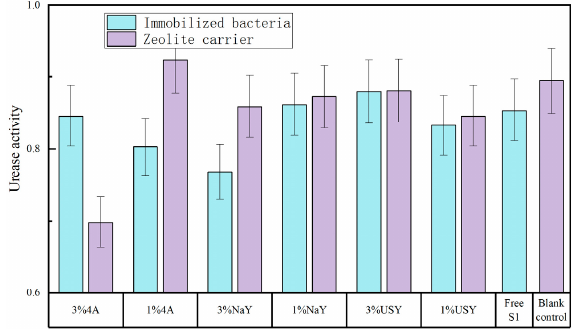
Figure 8. The effect of zeolite and bacteria on soil urease activity.